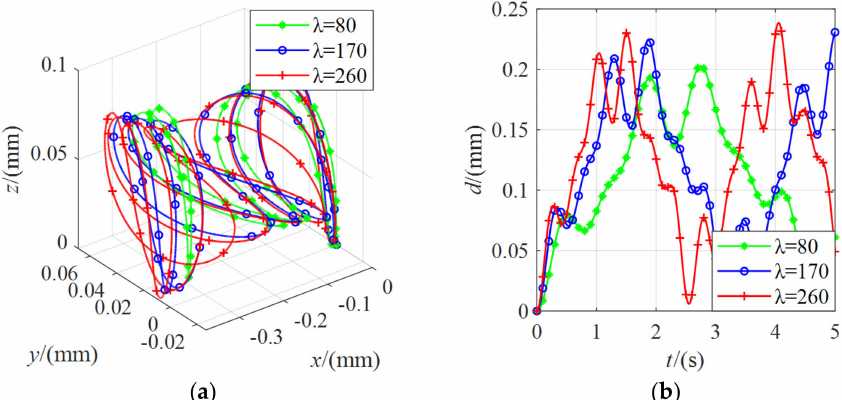
Figure 15. The position change of the moving platform under the external force of 0 N with different stiffnesses: ( a ) the coordinate curve of the moving platform center point in the spatial coordinate system O-xyz ; ( b ) the variation curve of the linear distance between the center point of the moving platform and the initial